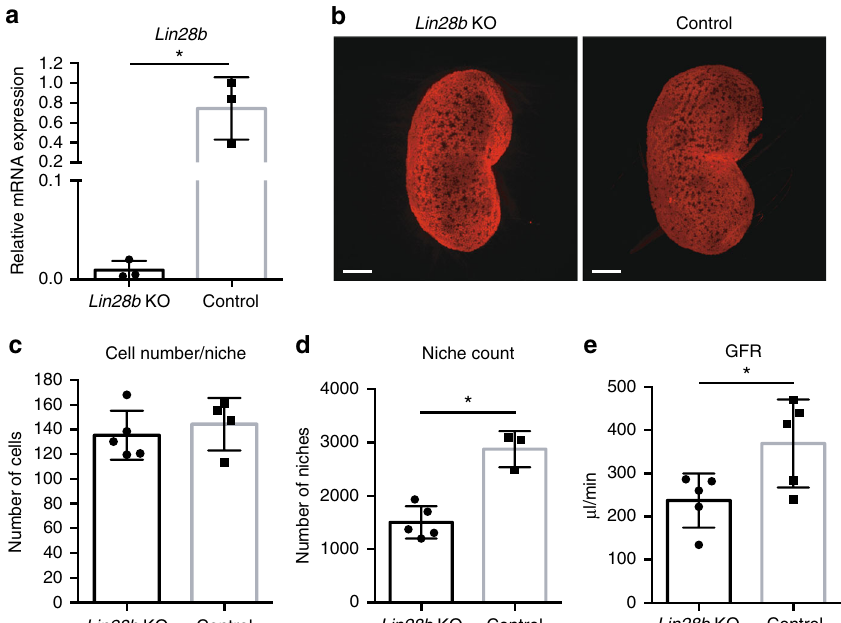
Fig. 4 Loss of Lin28b leads to impaired kidney development and function. a Relative qRT – PCR analysis measuring levels of Lin28b mRNA in Lin28b KO and control kidneys at E18.5. n = 3 for each group. b Representative Six2 optical projection tomography (OPT) of E18.5 Lin28b KO and control kidneys. Scale bar, 500 µ m. c , d The number of progenitors per niche and the number of niches, respectively, at E18.5. n = 3 – 5 for each group; each group contains mice from at least 2 different litters. e GFR and creatinine levels of Lin28b KO and littermate controls. Measured blindly in 2 – 3 m.o. animals. n = 5 for each sample type; each group contains mice from two different litters. Error bars represent mean ± SD. (*) = p < 0.05, unpaired, two-tailed Student ’ s t